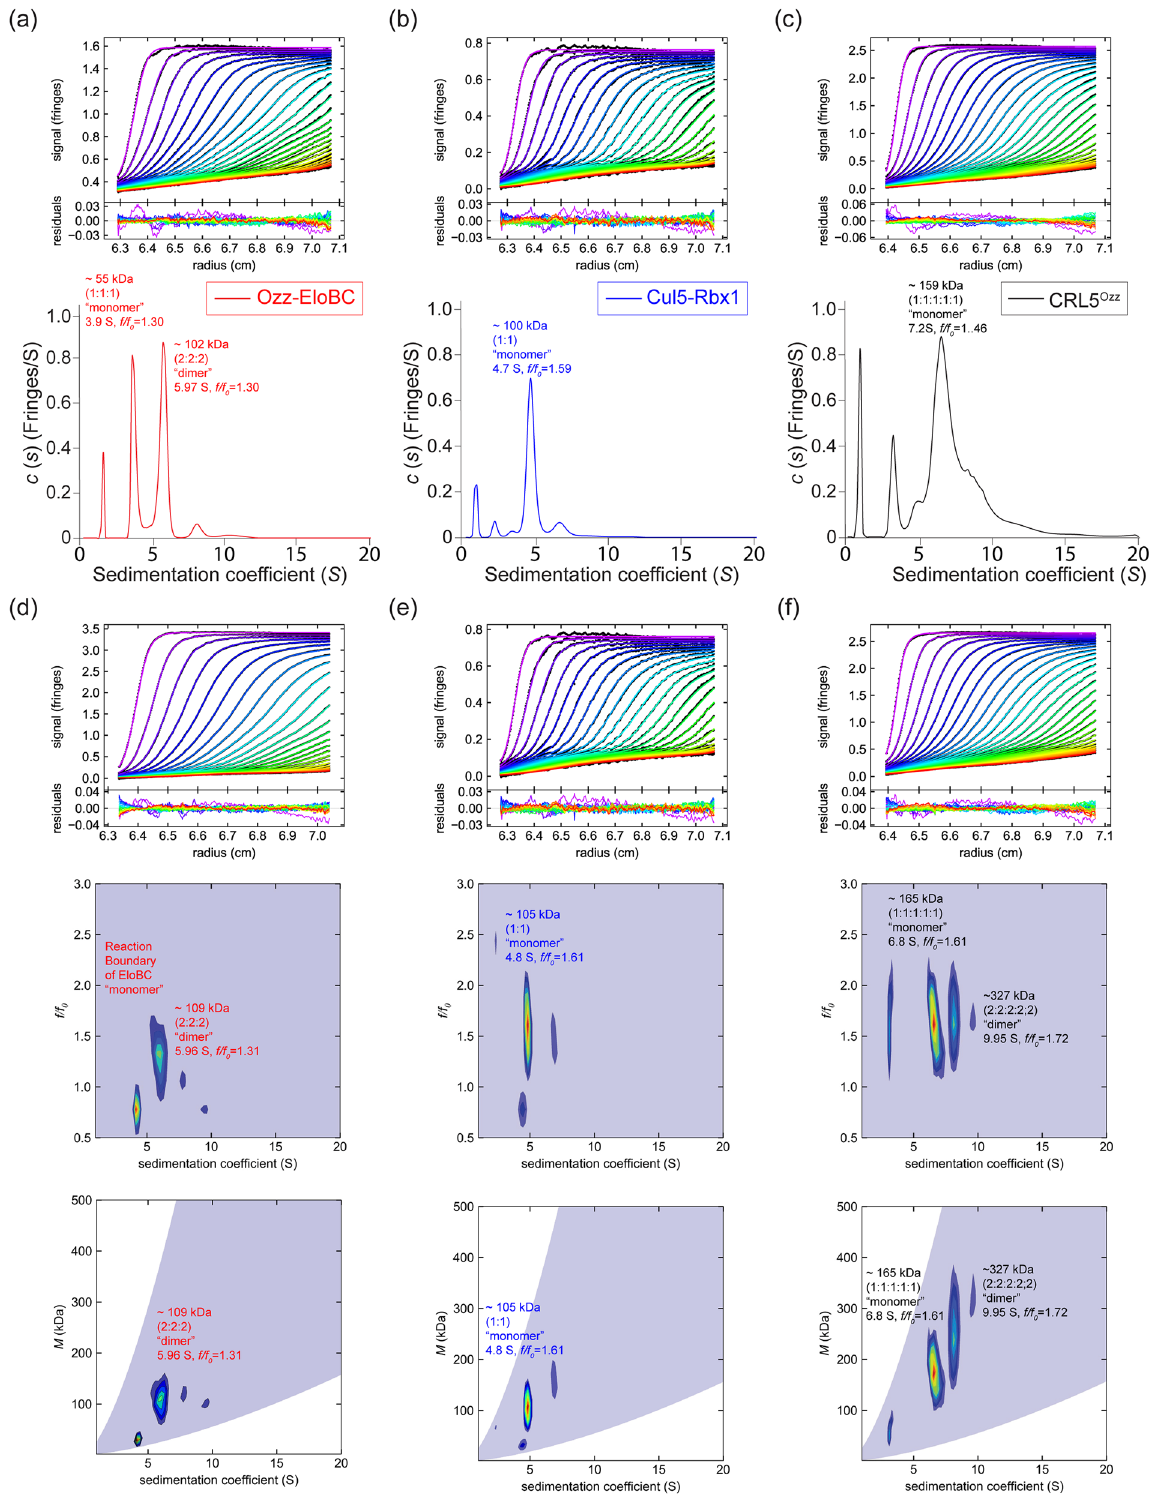
Figure 4. Sedimentation velocity—AUC analysis of Ozz–EloBC, Cul5–Rbx1, and CRL5 Ozz complex. Panels ( a – c ) Top panel: Fringe displaced sedimentation velocity profiles (fringes vs radius), with superimposed solid lines showing the best fit to the model, and below residuals of the fits. Bottom panel: display of the continuous sedimentation coefficient distribution c ( s ) plots of Ozz–EloBC (red line), Cul5–Rbx1 (blue line), and a mixture of the former two complexes (black line); ( d – f ) Top panel: fringe displaced sedimentation velocity profiles (fringes vs radius), with superimposed solid lines showing the best fit to the model, and below residuals of the fits. Middle panel: Contour plots (heat maps) of the two-dimensional size-and-shape distributions, c ( s,f/f 0 ) and Bottom panel: Molar mass distributions c ( s,M ), of Ozz–EloBC, Cul5–Rbx1 and a mixture of Ozz–EloBC and Cul5–Rbx1, respectively. The experiments were conducted in 137 mM NaCl, 0.27 mM KCl, 10 mM Na2HPO4 and 1.8 mM KH2PO4 pH 7.2 buffer at 20 °C and at a rotor speed of 50,000 rpm. The s-, f/f 0 and M -values of the protein complexes are listed in Tables 2 and